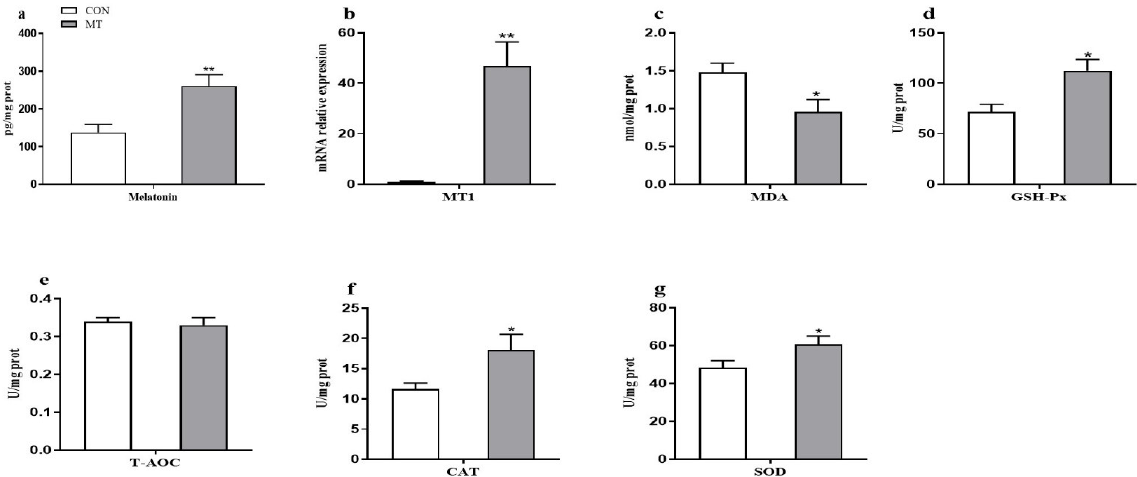
Figure 4. Effects of maternal MT supplementation during gestation on antioxidant status in the placenta. ( a ) MT concentration in placenta. ( b ) mRNA relative expression of MT1. ( c ) MDA concentration. ( d ) GSH-Px activity. ( e ) T-AOC concentration. ( f ) CAT activity. ( g ) SOD activity. Data are presented as means ± SEM, n = 8. * p < 0.05, ** p < 0.01. CON = control, MT = melatonin, MT1 = melatonin receptor 1A.